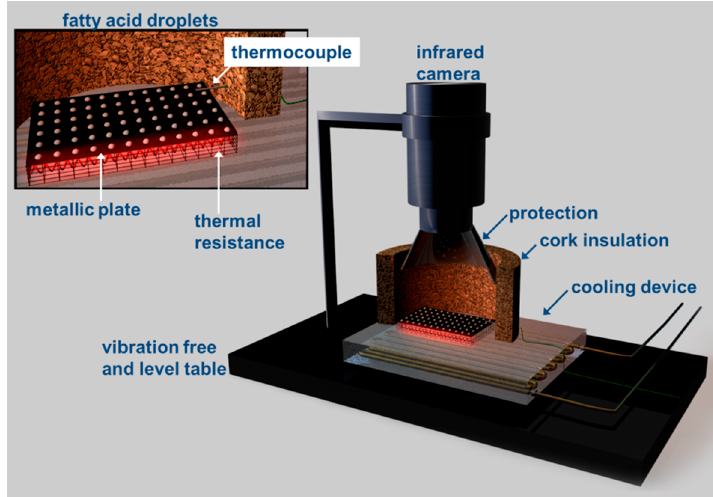
Figure 1. Sketch of the experimental setup.